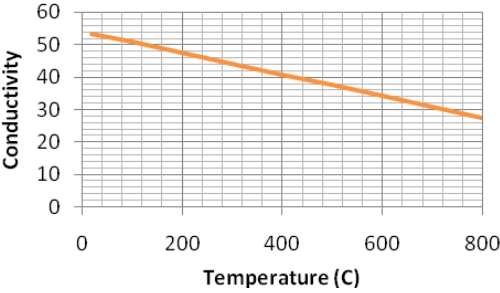
Fig. 5. Conductivity versus